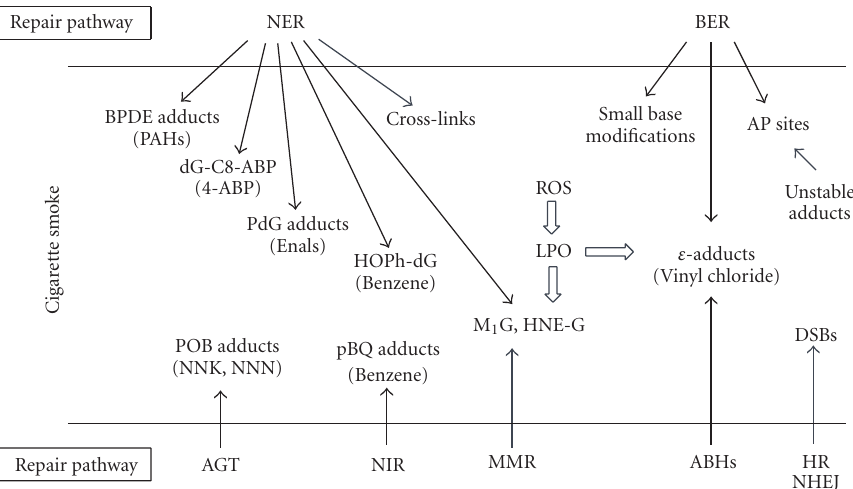
Figure 7: Summary of specificity of repair of tobacco carcinogen-induced bulky DNA adducts by the major DNA repair pathways. Some of the nonbulky DNA lesions and their repair mechanisms are also presented. For example, DSBs caused by cigarette smoke are repaired by nonhomologous end joining (NHEJ) and homologous recombination (HR). Note that overlapping substrate specificity is